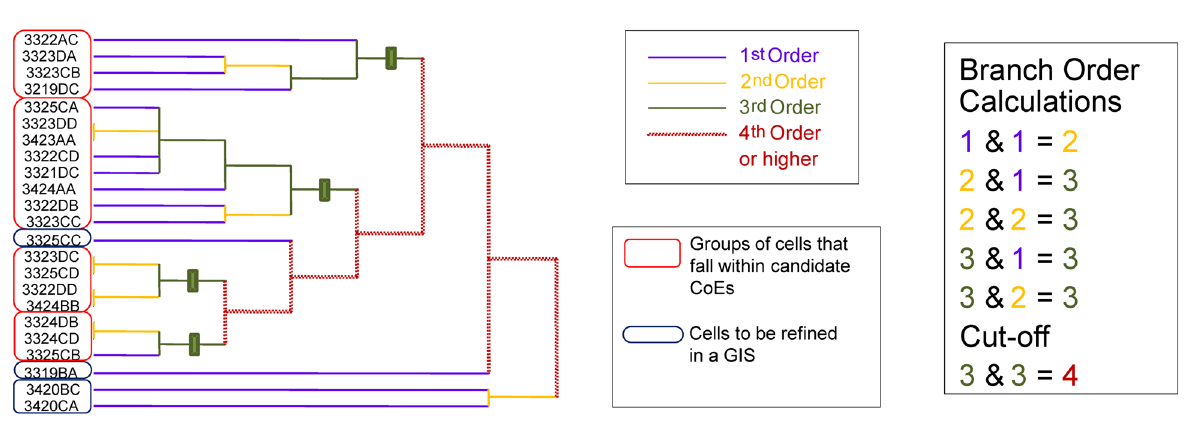
Fig 3. A diagrammatic example of the modified third order branch cut-off (BOC3m). The cut-offs are displayed as bold vertical lines (green), and the resulting candidate CoE clusters are indicated with red blocks around the